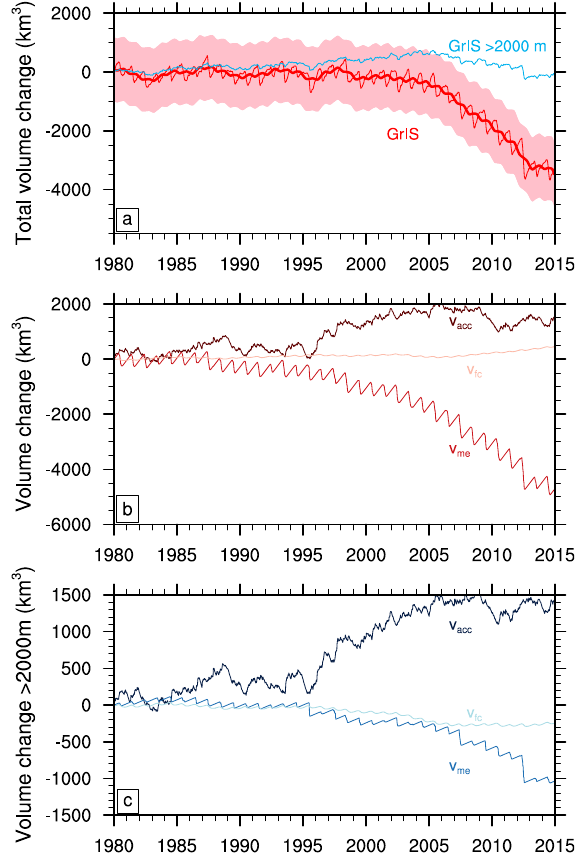
Figure 11. (a) Ice-sheet-integrated volume change for 1980–2014 (in km 3 ) due to firn and SMB processes. The thin red line is the vol- ume change based on weekly output from the firn model; the thick red line is a 1-year running average; and the pink shaded area shows the uncertainty estimate. The blue line shows the volume change for the part of the ice-sheet surface elevated more than 2000ma . s . l . (b) Partitioning of the total volume change into the three main components: accumulation v acc , melt v me , and firn compaction v fc . (c) Like (b) but for the ice sheet higher than 2000ma . s . l